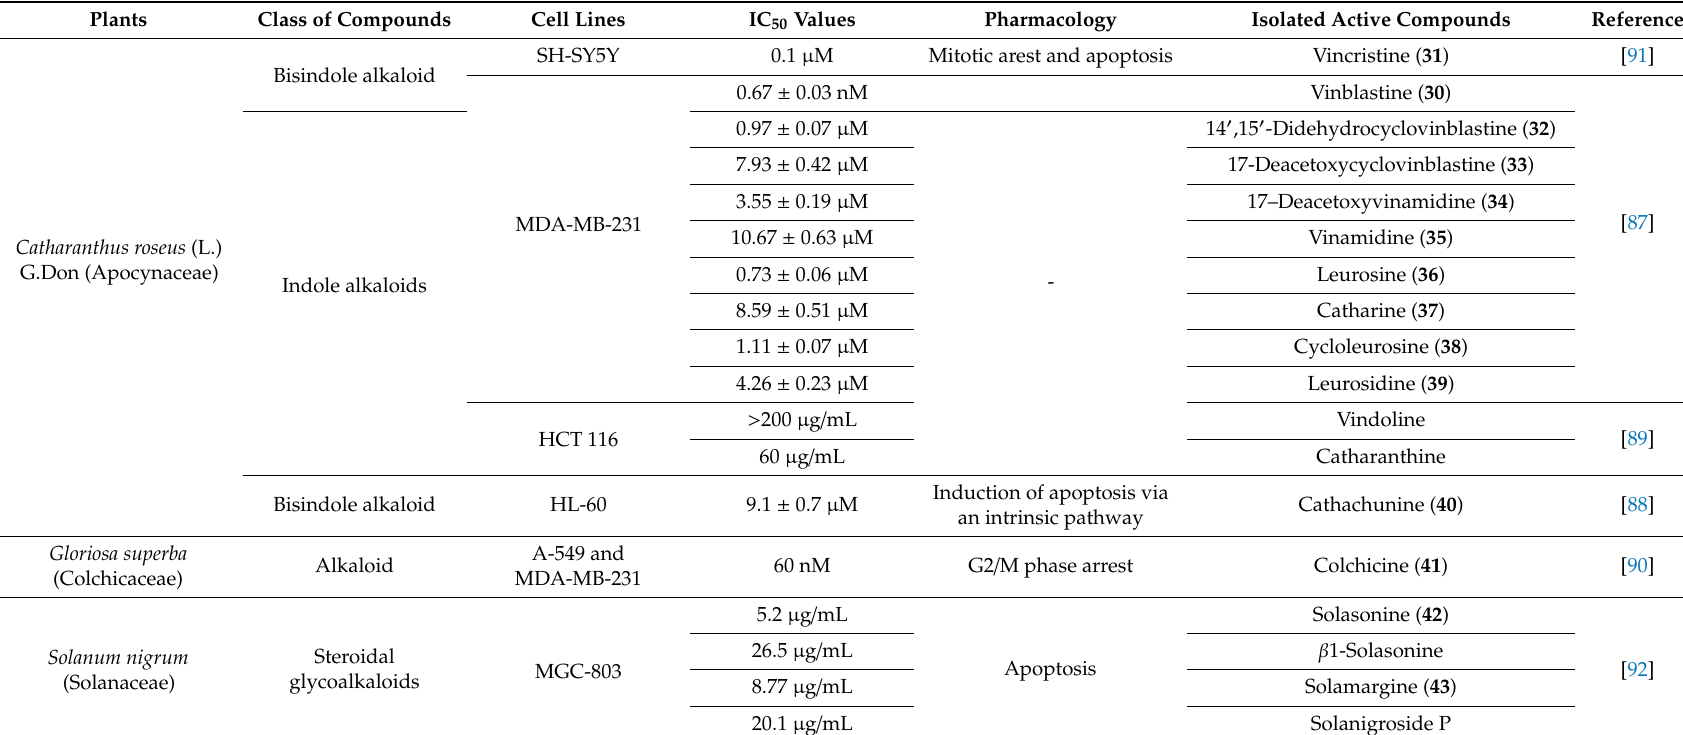
Cell lines: MDA MB 231 = Triple-negative breast cancer, SW480 = Human colorectal, HCT116 = Human colorectal carcinoma, HL60 = Human promyelocytic leukemia, MCF-7 = Human breast adenocarcinoma, SMMC-7721 = Human hepatocarcinoma, A-549 = Human lung adenocarcinoma, MGC-803 = Human gastric cancer. IC 50 = Concentration that inhibited cell proliferation by